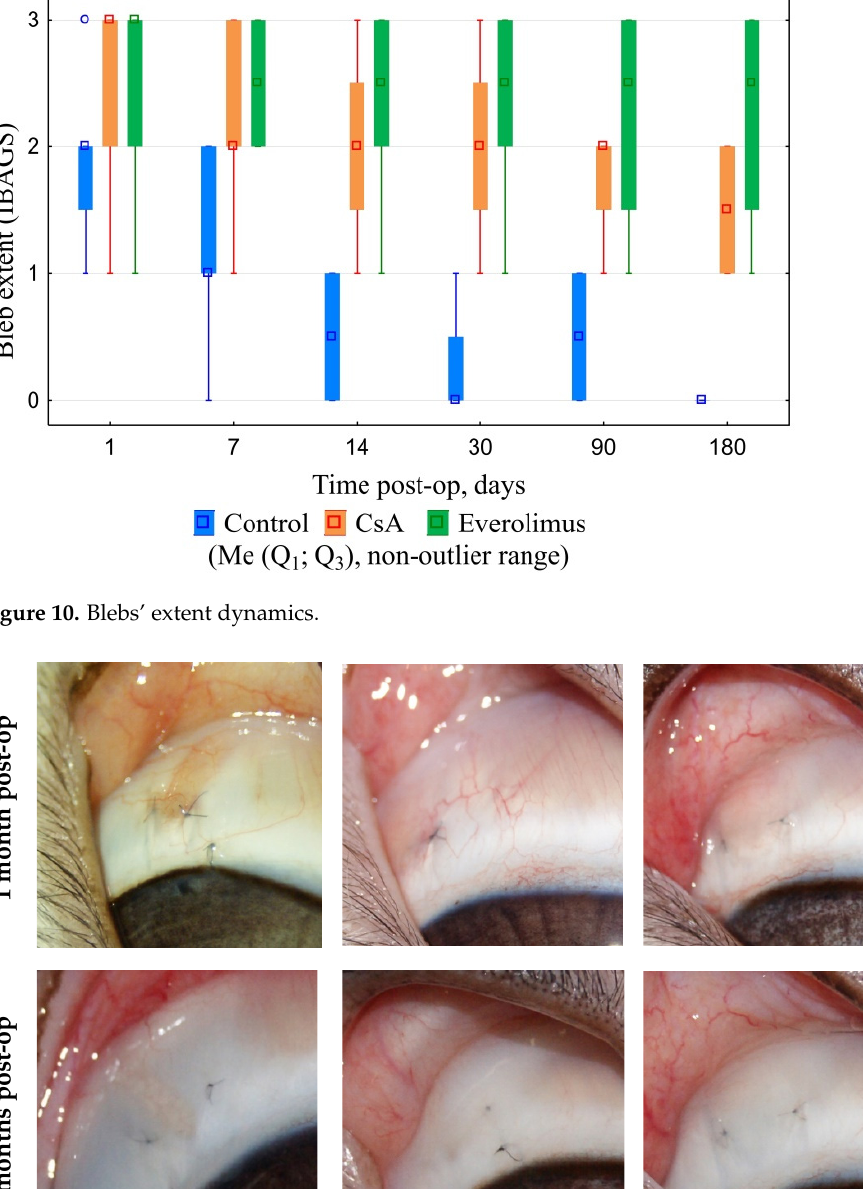
Figure 9 . Blebs’ height dynamics .